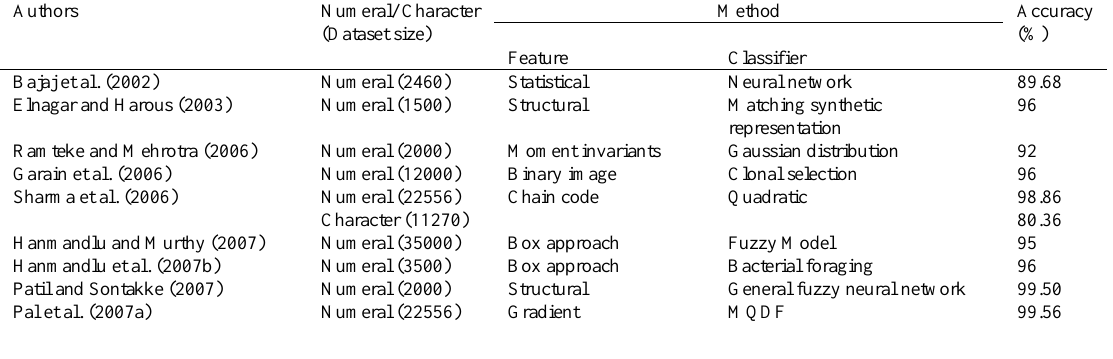
Table 2. Comparative study of recognition results in Devanagari